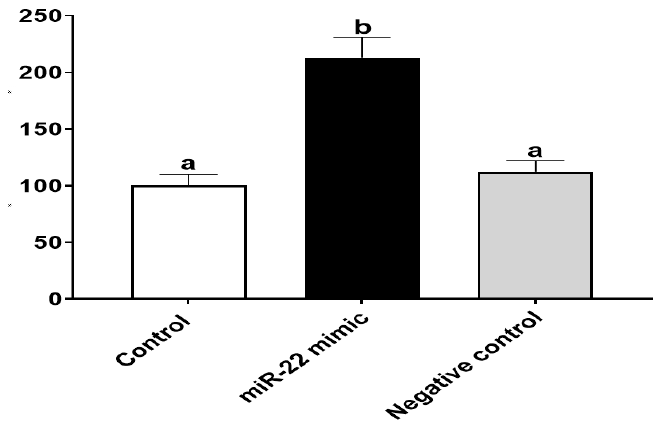
Figure 3. miR-22 promotes proliferation of HIECs. After HIECs were transfected miR-22 for 24 h,